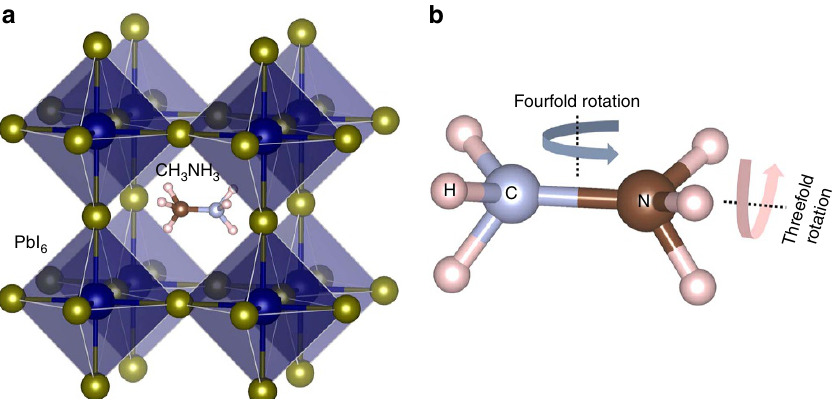
Figure 1 | Crystal structure of CH 3 NH 3 PbI 3 . ( a ) The schematic diagram of the perovskite structural unit. The organic cation is located in the centre of PbI 6 octahedral cage. The real structures are complex due to the orientational disorder of organic cations. ( b ) Geometry of the molecule with schematic drawing of the threefold and fourfold jumping rotational modes.